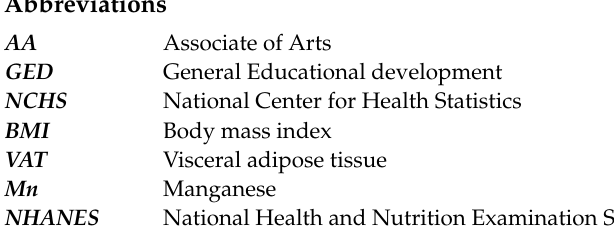
participants. Table S2. Sensitive analysis I for associations between manganese exposure and VAT mass. Table S3. Sensitive analysis II for associations between manganese exposure and VAT mass. Table S4. Sensitive analysis III for associations between manganese exposure and VAT mass. Table S5. Sensitive analysis IV for associations between manganese exposure and VAT mass. Table S6. Sensitive analysis V for associations between manganese exposure and VAT